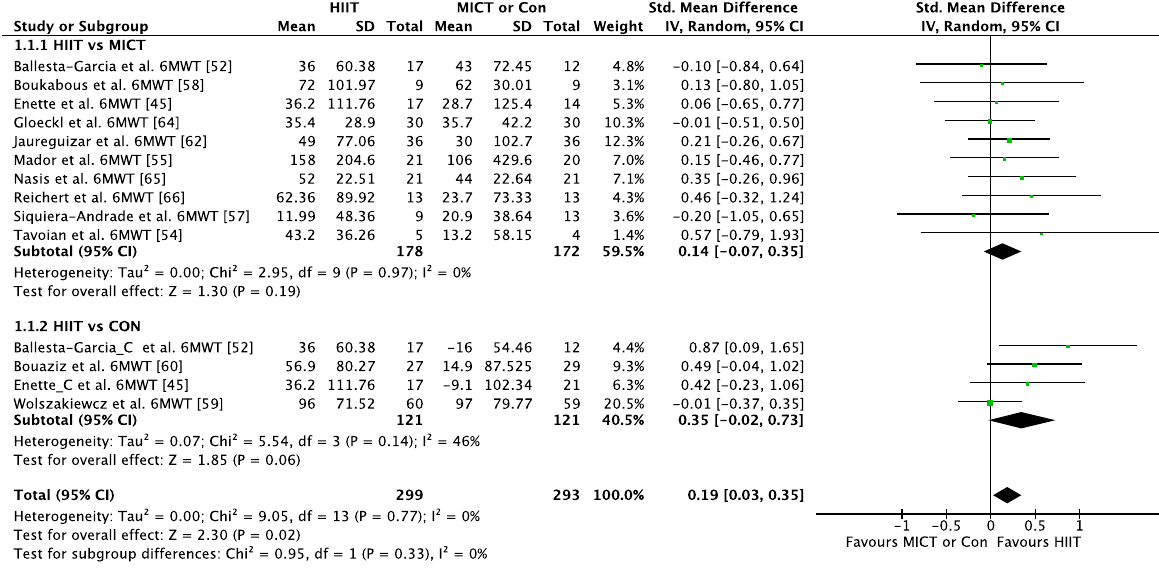
Fig. 4 Meta-analysis subgroups HIIT versus MICT, HIIT versus Control with 6MWT outcome measure